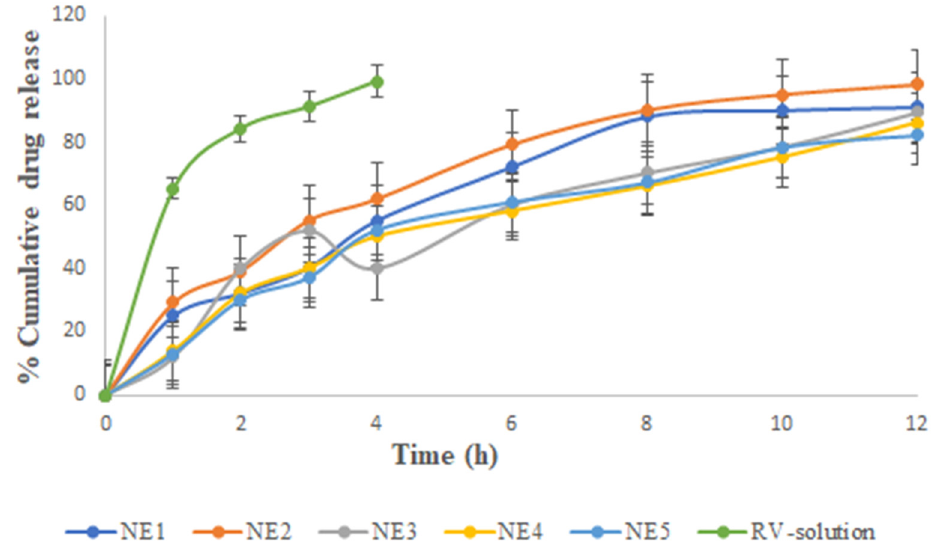
Figure 2. Percentage of cumulative drug release vs. time for the various selected nanoemulsions and RV solution. The average value SD ( n = 3) is represented by each cross bar. NE: nanoemulsion.